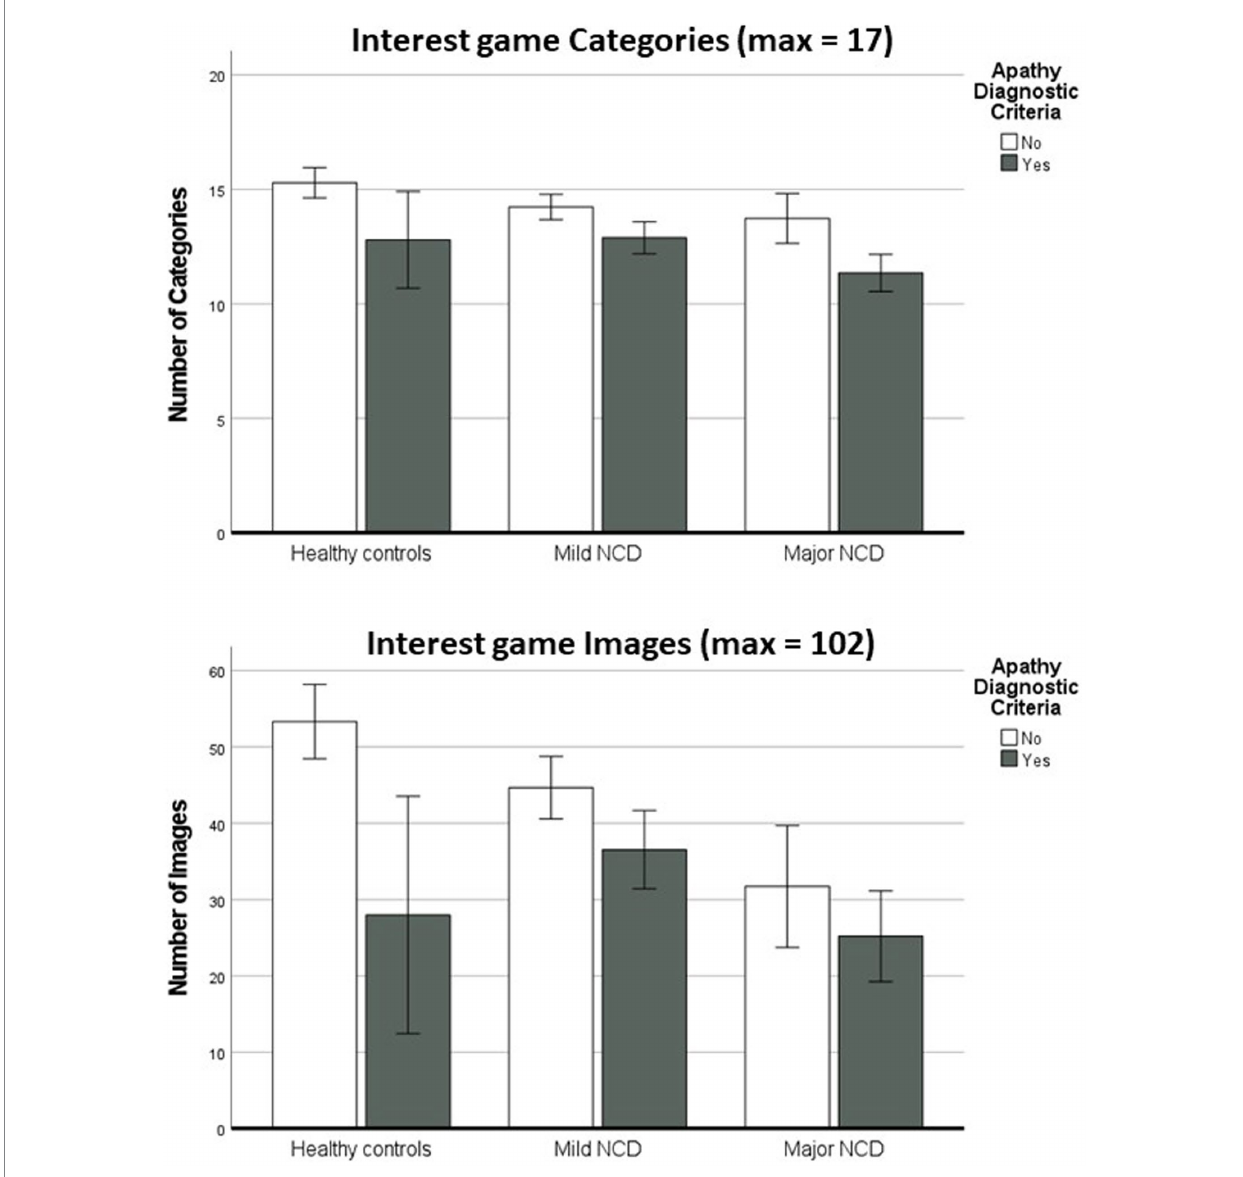
FIGURE 2 Interest game results (Categories and Images) for apathetic and non-apathetic participants in the three diagnostic groups Error bars represent ±2 standard